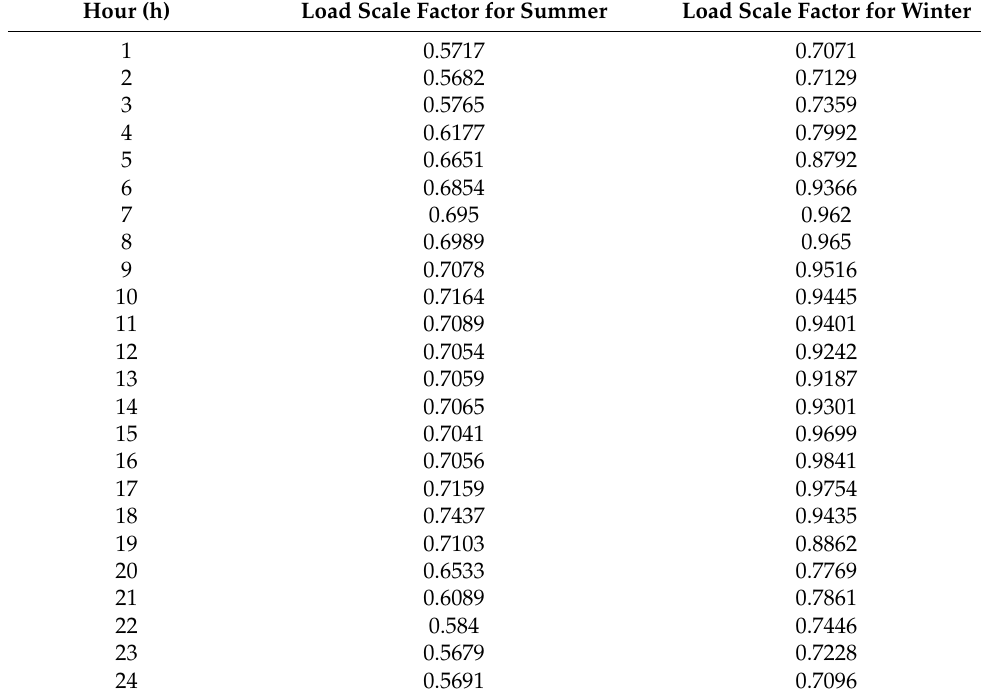
Table 3. Load scale